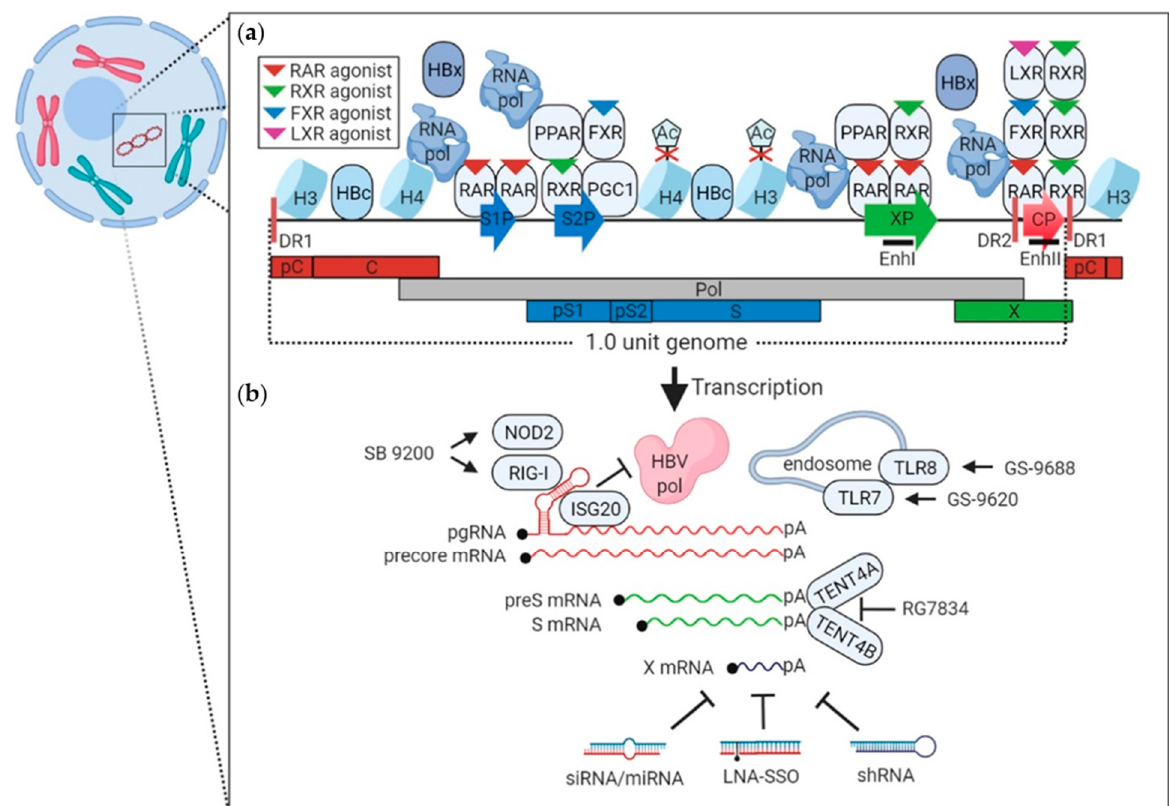
Figure 2. Approaches to inhibit transcription and interfere with viral transcripts. ( a ) The 1.0 unit genome is packaged with essential host factors, histone 3 (H3) and 4 (H4), RNA polymerase (RNA pol), as well as associated HBcAg (HBc) and HBx. Agents that block the acetylation of H3 and H4 (red cross) repress general transcription. Homodimers (i.e., RAR-RAR) and heterodimers (i.e., RAR-RXR, FXR-RXR, LXR-RXR, etc.) bind specific promoter and enhancer regions and maintain transcription. When RAR, RXR, FXR, and LXR agonists (shown as inverted triangles and summarized in Table 1) bind these nuclear receptors, transcription from the HBV promoter is suppressed. Core (CP), preS (S1P), S (S2P), and X promoters (XP) are shown as arrows overlaid onto the 1.0 unit HBV genome. Each promoter controls the transcription of core (pC-C, shown in red), polymerase (Pol, in gray), S (pS1-pS2-S, in blue), and X (in green) open reading frames, respectively. Two enhancers (EnhI and EnhII, thick black line) are marked along with direct repeat elements (DR1 and DR2, thick red line). ( b ) TLR7 (i.e., GS-9620) and TLR8 agonists (i.e., GS-9688) induce endosome-mediated sensing of single-stranded viral transcripts. Targeting pgRNA (red), ISG20 prevents HBV polymerase (pol) binding to the pgRNA, while RIG-I/NOD2 agonists (i.e., SB 9200) promote RIG-I specific binding to the ε region in the pgRNA, which competes for polymerase-pgRNA association and subsequent virion encapsidation. PreS and S mRNAs (green) are stabilized by host enzymes TENT4A/B (PAPD5/7), which can be inactivated by a specific inhibitor, RG7834. In addition to small molecules, RNA interference mediates the degradation of all HBV transcripts including X mRNA. Locked nucleic acids (LNA-SSO), small hairpin RNA (shRNA), small interfering RNA (siRNA), as well as microRNA (miRNA) have been developed to bind viral transcripts, mediating their decay.